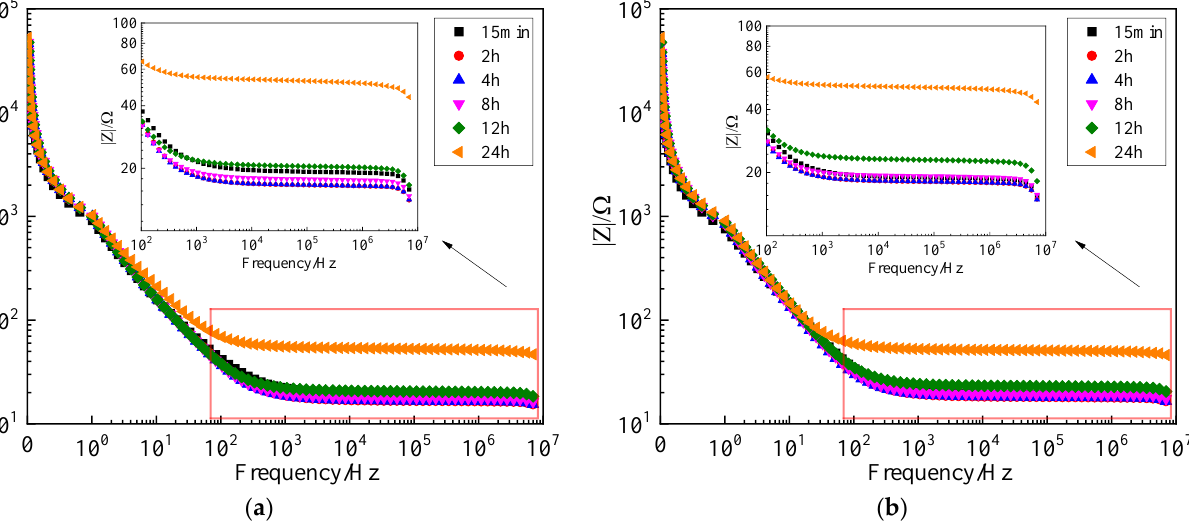
Figure 6. Bode plots with impedance modules of cement paste with superplasticizer addition. ( a ) SP − NP0; ( b ) SP − NP1.